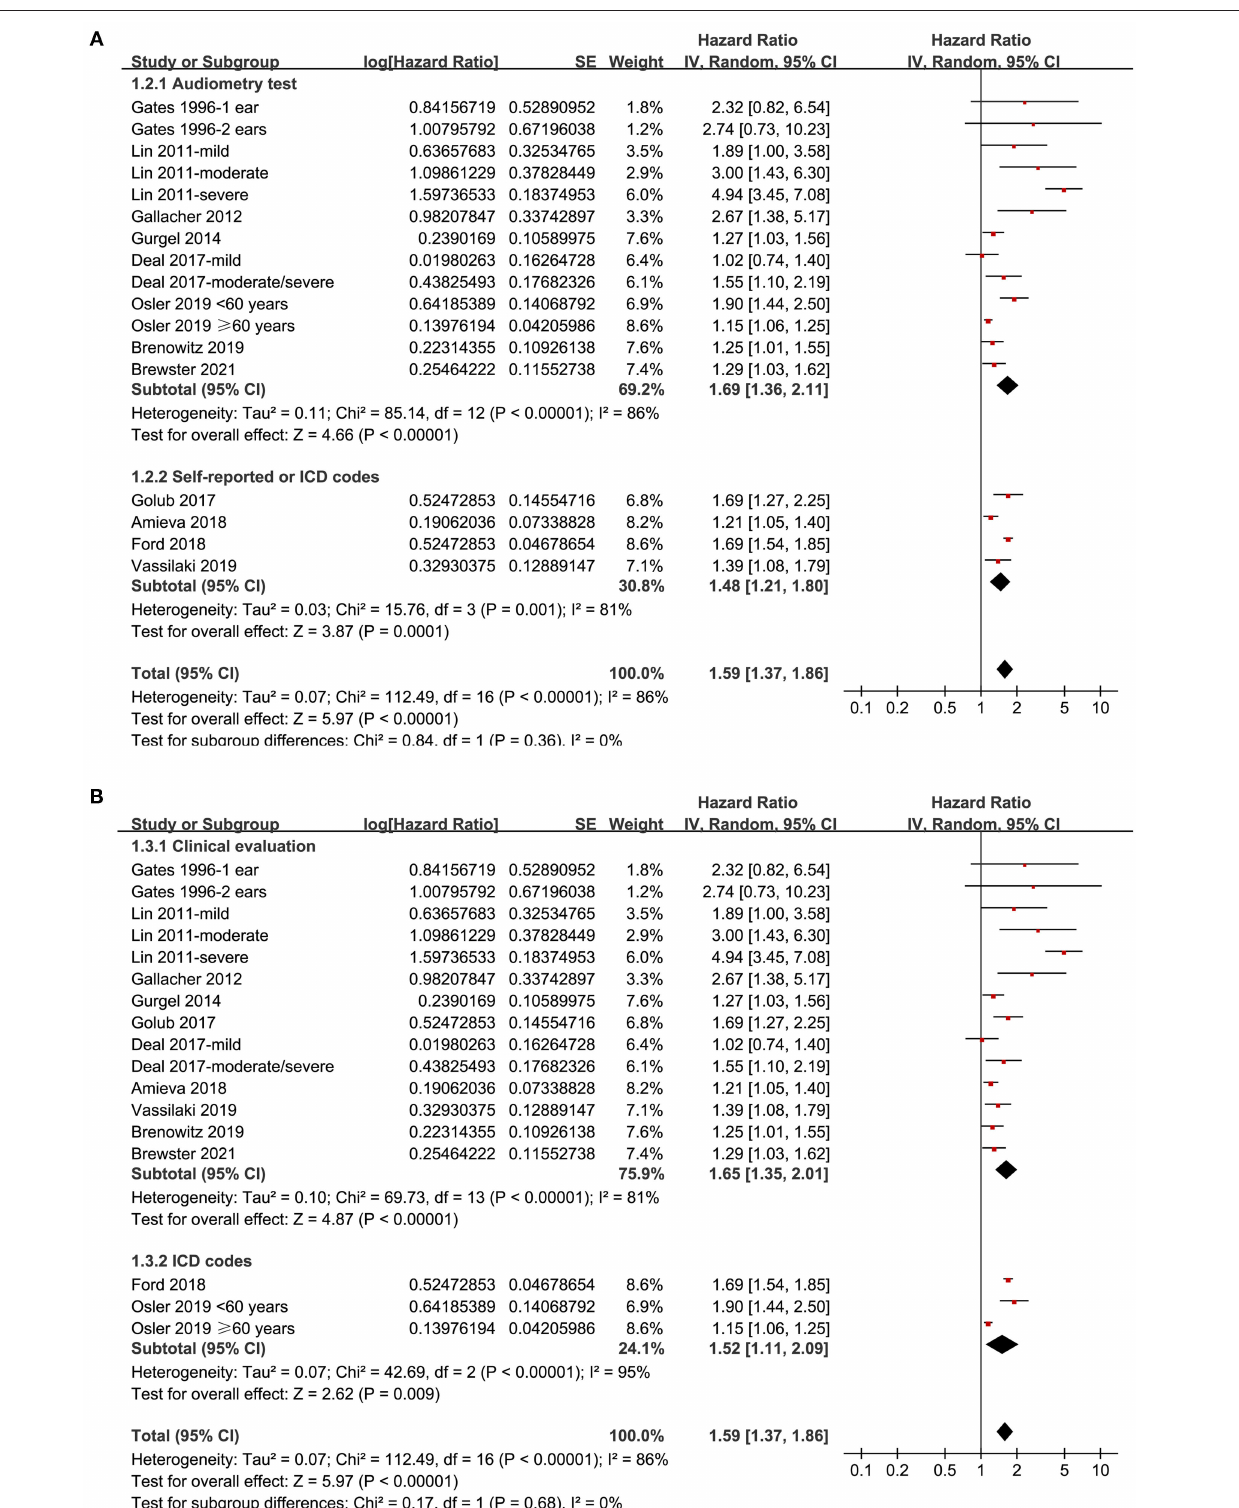
Frontiers in Aging Neuroscience |